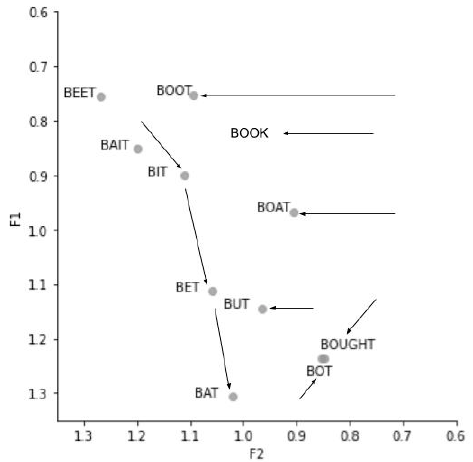
Figure 1. California Vowel Shift (adapted from D’Onofrio et al. (2019)).